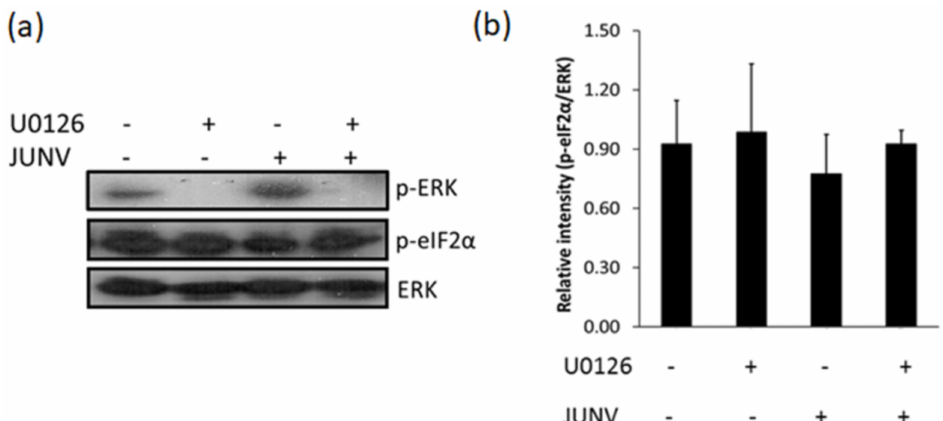
Figure 6. U0126 does not affect eukaryotic initiation factor 2 α (eIF2 α ) phosphorylation. ( a ) Uninfected and JUNV infected (m.o.i. = 1) Vero cells were treated with U0126 during 12 h or were left untreated. Then cells were lysed and the level of eIF2 α and ERK phosphorylation was assessed by Western blot; ( b ) Quantification of p-eIF2 α , data represent mean values of relative intensity with respect to ERK ±